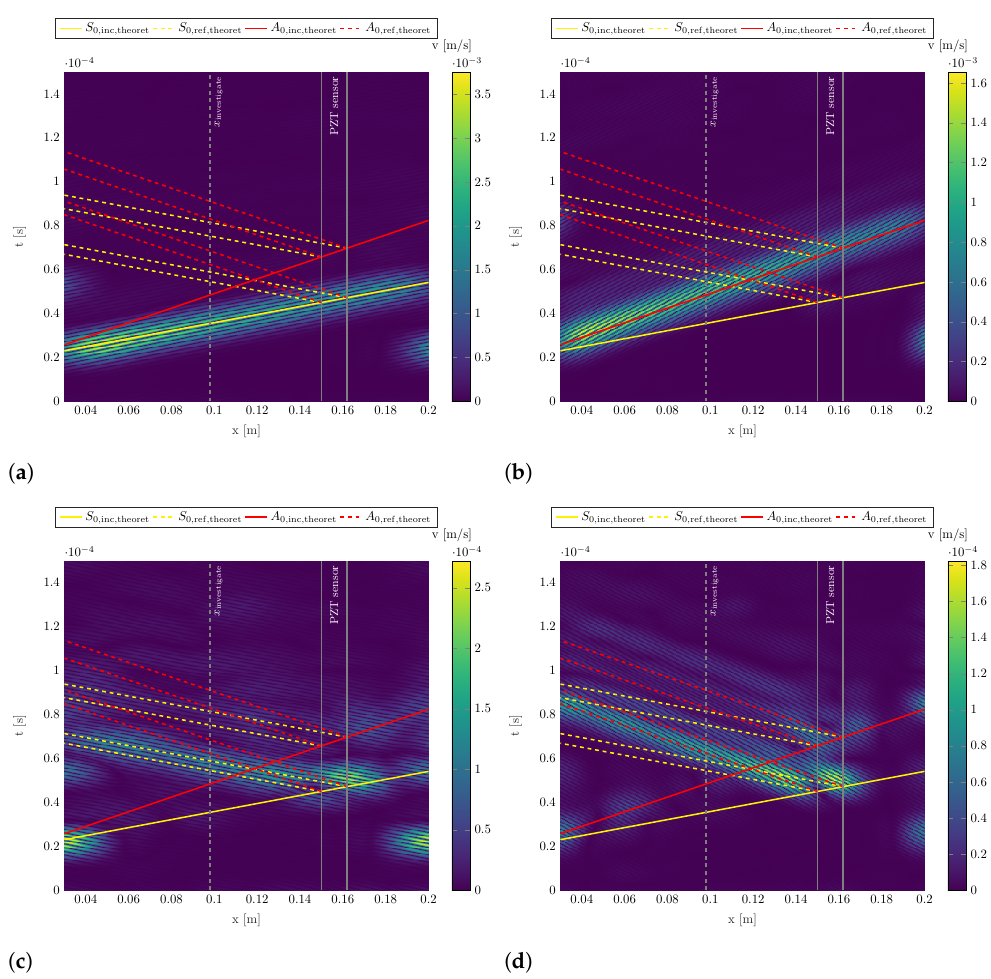
Figure 8. Filtered B-scans for identifying incident and reflected S 0 and A 0 modes for an excitation with a burst center frequency of f c = 300kHz. 2mm aluminum plate with surface-applied PZT ceramic. ( a ) Filtered incident S 0 mode from in-plane data. ( b ) Filtered incident A 0 mode from out-of-plane data. ( c ) Filtered reflected S 0 mode from in-plane data. ( d ) Filtered reflected A 0 mode from out-of-plane